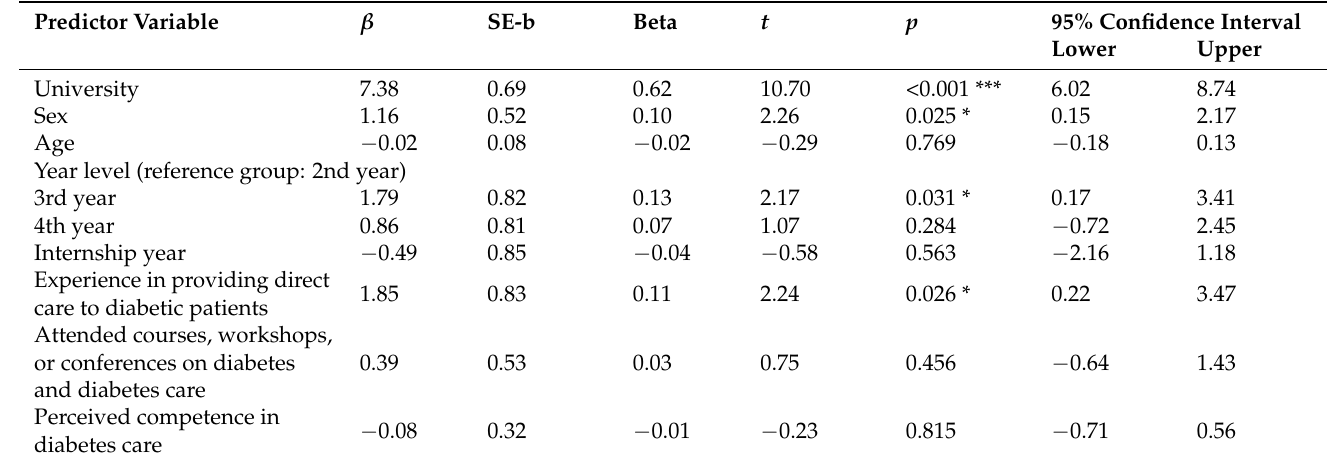
Table 3. Results of the multiple regression analysis to identify the predictors of perceived knowledge ( n = 330).